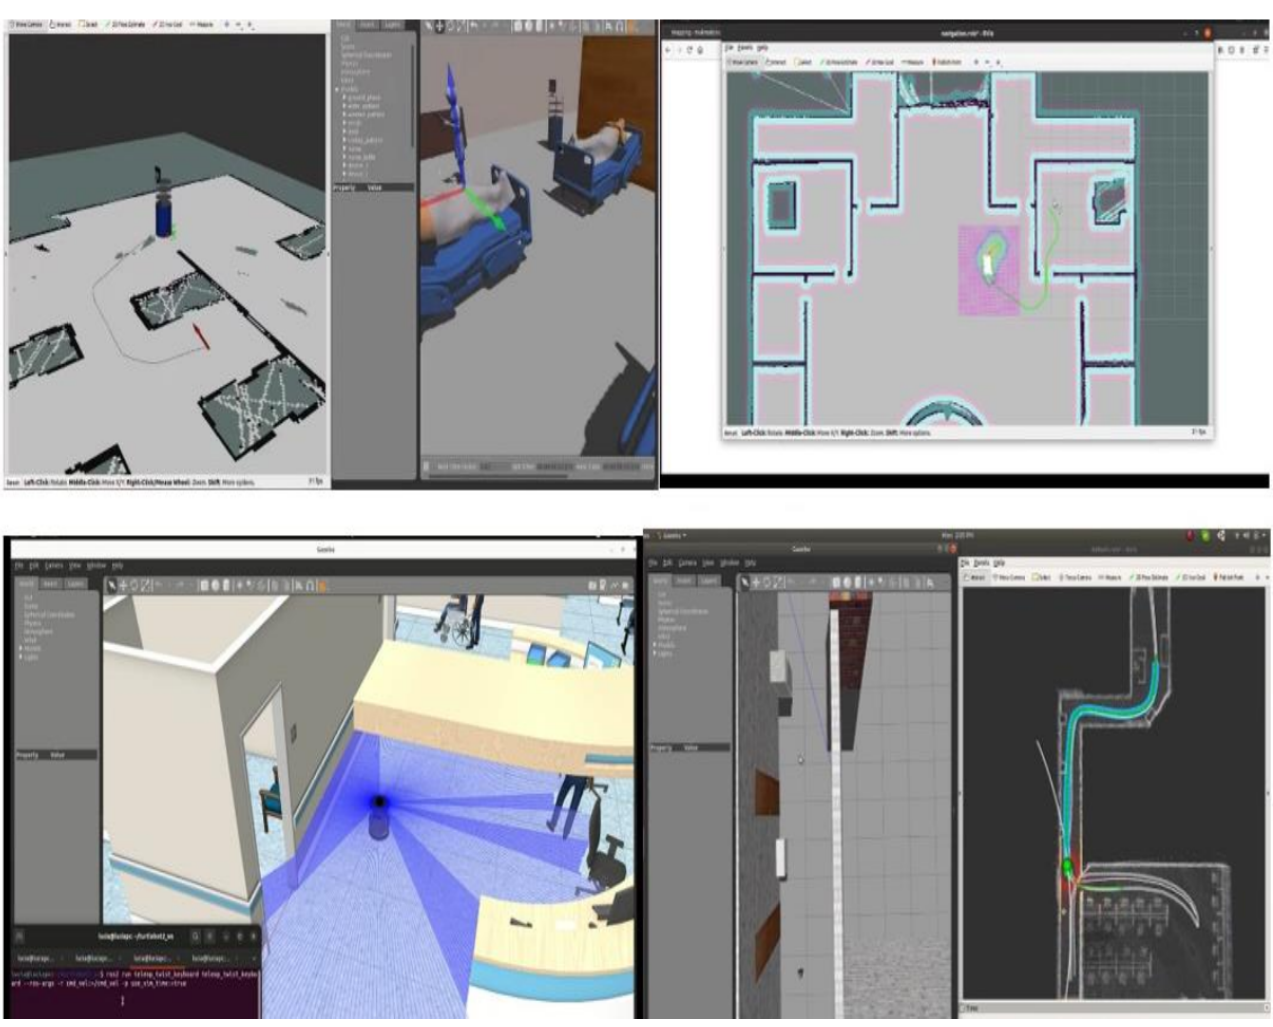
Figure 10. Different environmental simulations using Gazebo software.